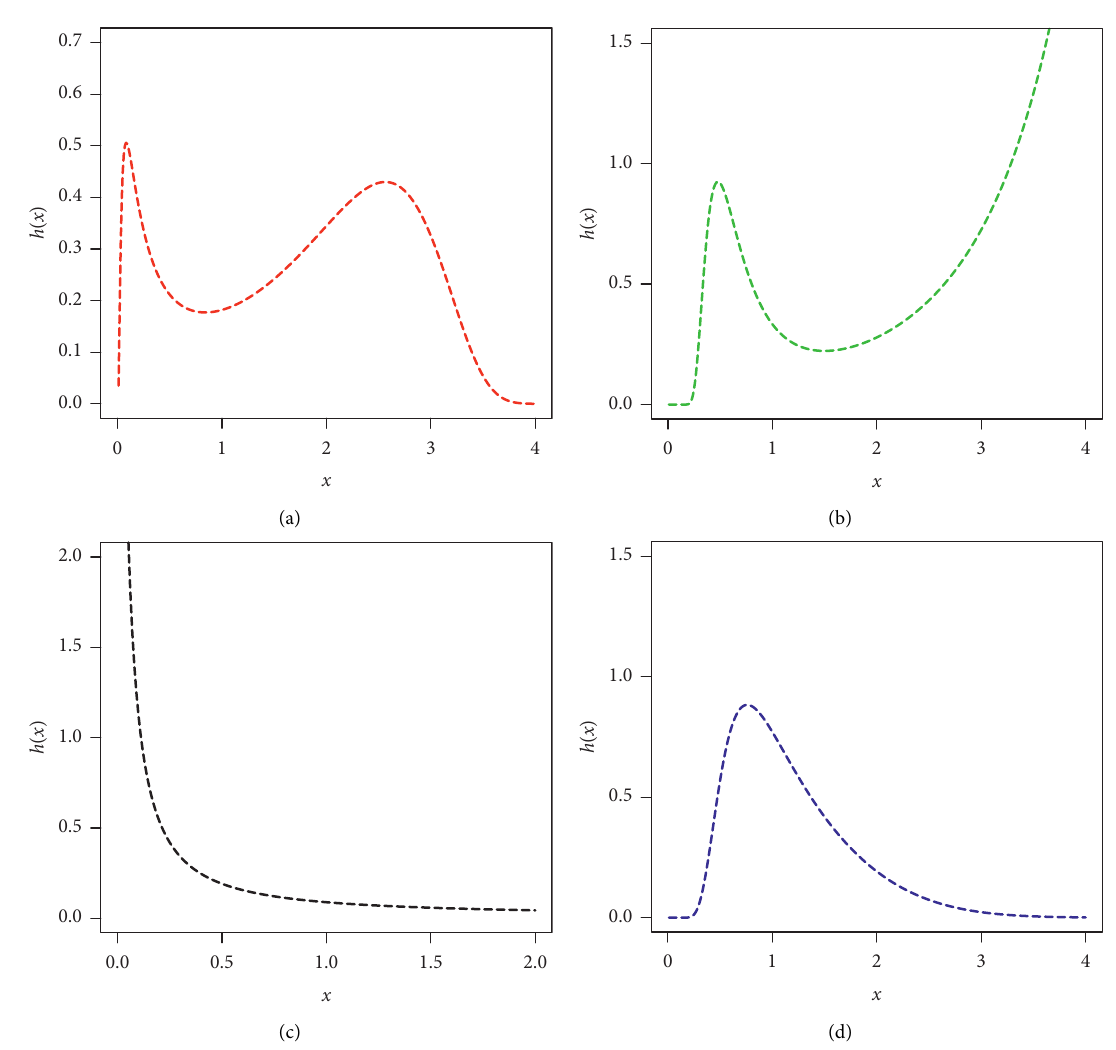
Figure 2: Different PDF plots of the ASNFEW